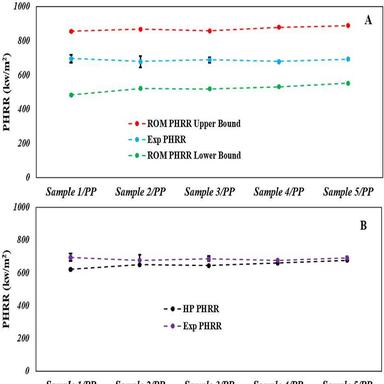
Graph of predicted vs. experimental (Exp) Peak heat release rate, PHRR values (A. Verbeek; B. Halpi-Pegano, HP). The graphs show the extent of correlation between the predicted PHRR values (obtained using cone calorimeter test of the individual rice husks) and the experimental PHRR values (obtained using cone calorimeter test of the respective composites). The closer the predicted and the experimental values, for each sample, the better is the prediction. (For interpretation of the references to colour in t